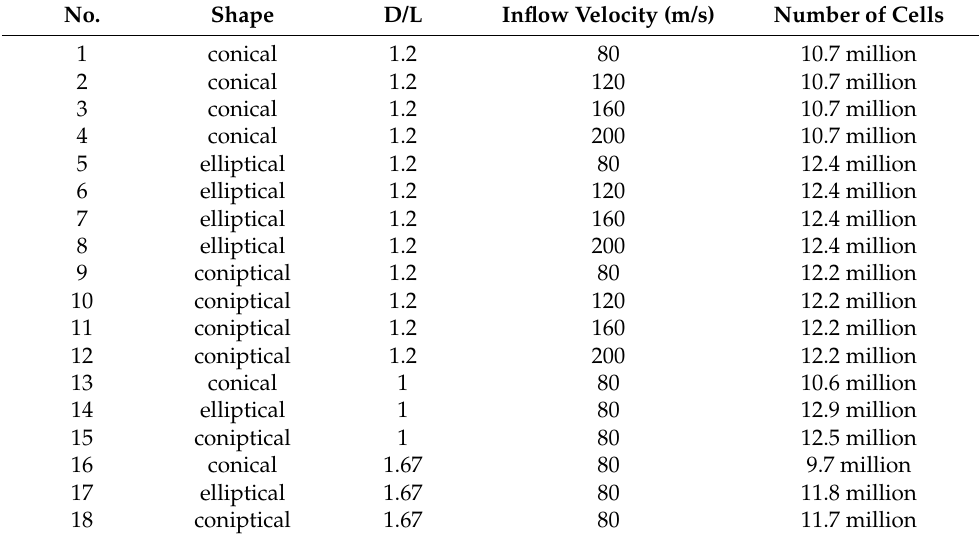
Table 1. Model and working condition.